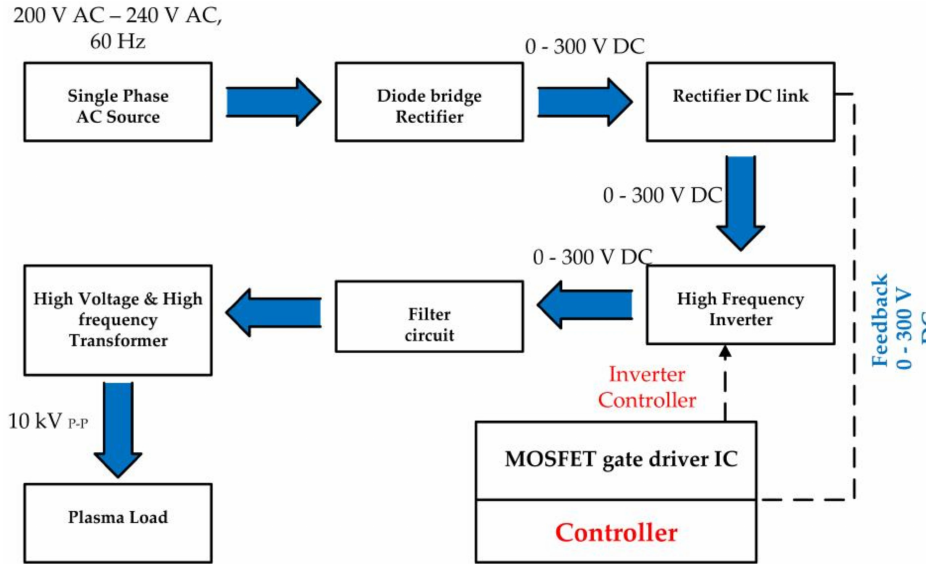
Figure 2. Block diagram of the high voltage high frequency (HVHF) plasma switching power